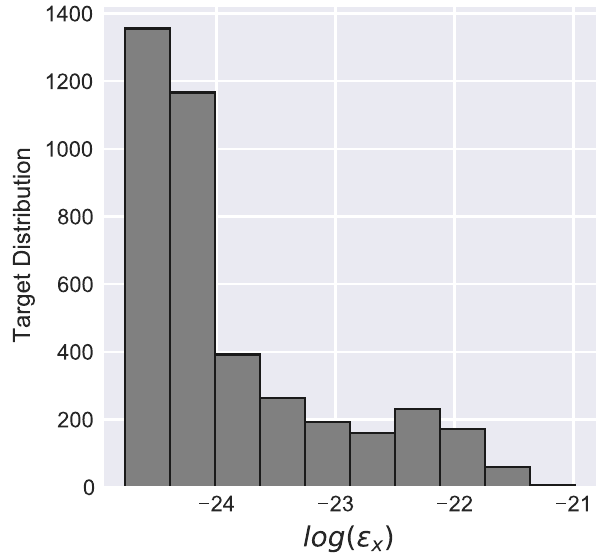
FIG. 7. Histogram outlining the distribution of log emittance in the learning dataset.